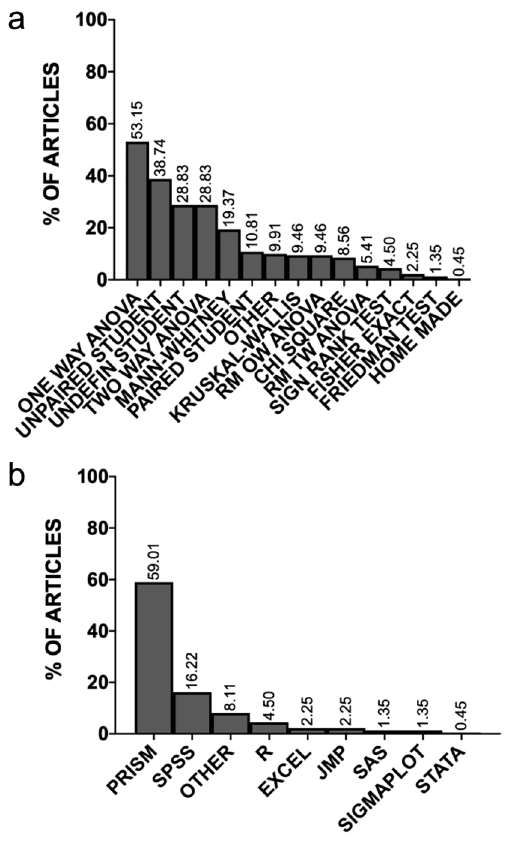
Figure 3. Histograms showing the frequency distributions of tests (A) and software (B). The Y axis gives the percentage of articles with the given item. Note that the overall sum of percentages may be above 100% since more than one test (in A) or type of software (in B) may be present in a given article (k = 223